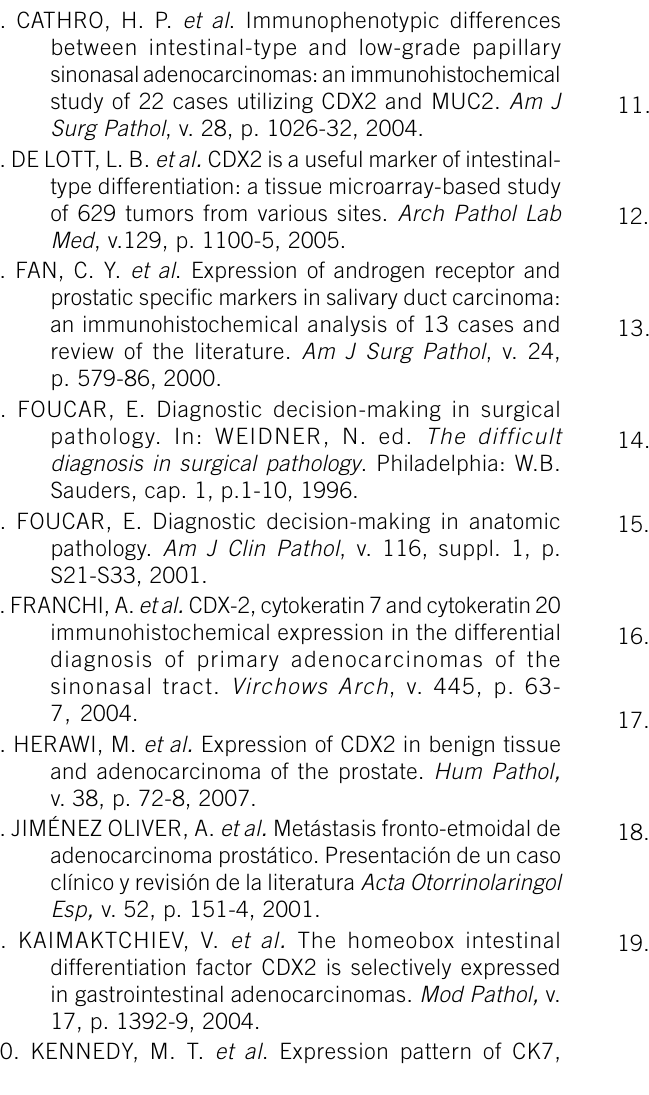
CK20, CdX-2, and villin in intestinal-type sinonasal adenocarcinoma. J Clin Pathol , v. 57, p.